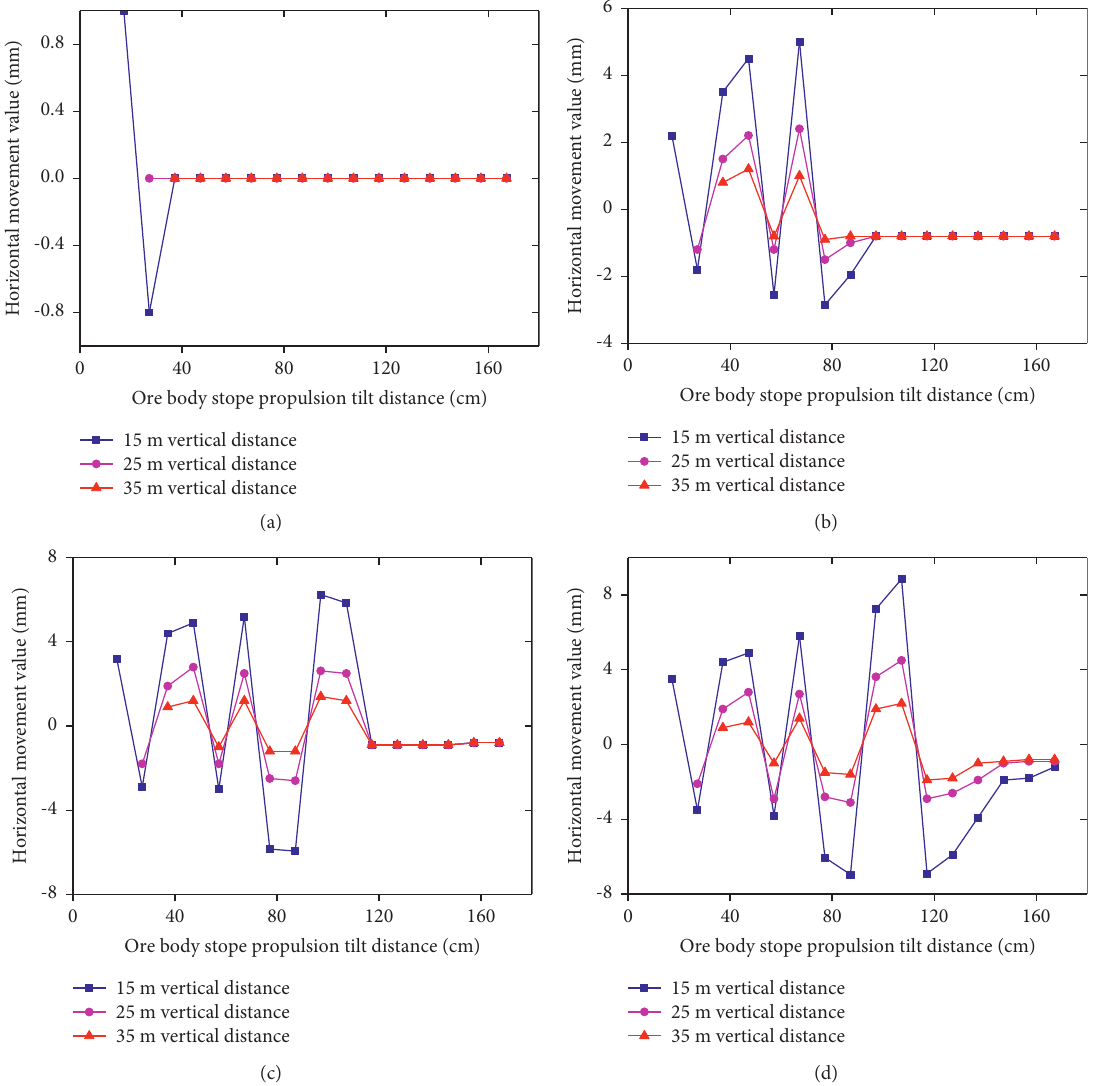
Figure 6: Surveying variation curve of horizontal displacement follows each exploit progress (20 ° ). (a) Variation curve of horizontal displacement after 1-step excavation at each measuring point. (b) Variation curve of horizontal displacement after 3-step excavation at each measuring point. (c) Variation curve of horizontal displacement after 5-step excavation at each measuring point. (d) Variation curve of horizontal displacement after 5-step excavation at each measuring